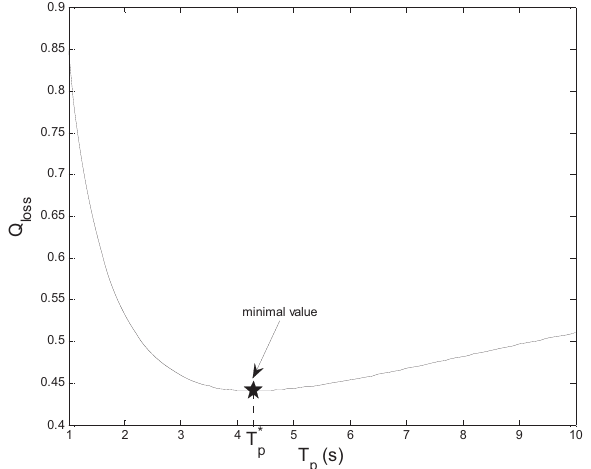
Figure 7. Total sensing loss probability vs. sensing